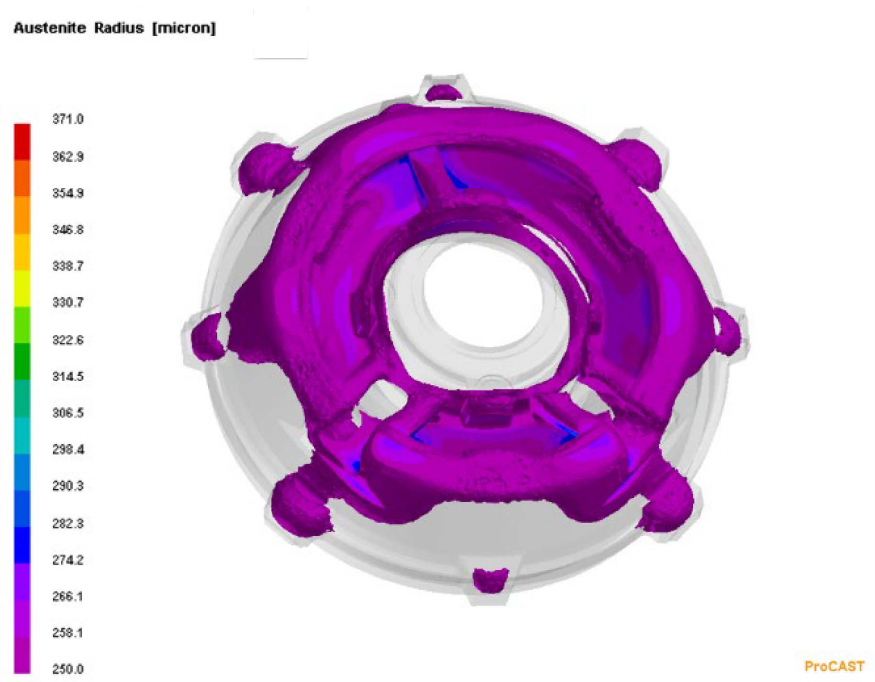
Figure 12. Distribution of primary austenite grains with diameters that were smaller than 250 µ m, with a large number of primary austenite nucleation sites.